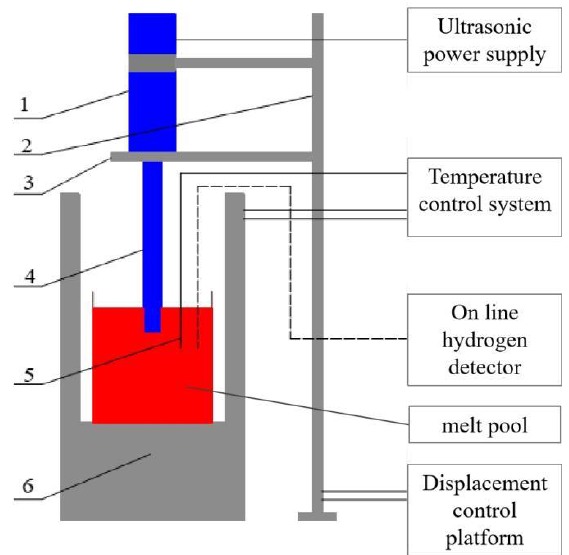
Figure 1. Schematic diagram of the Al-Cu alloy experimental device for ultrasonic-assisted casting. 1: ultrasonic transducer; 2: positioning support flange; 3: displacement control device; 4: ultrasonic horn; 5: thermocouple; 6: resistance-wire heating furnace.